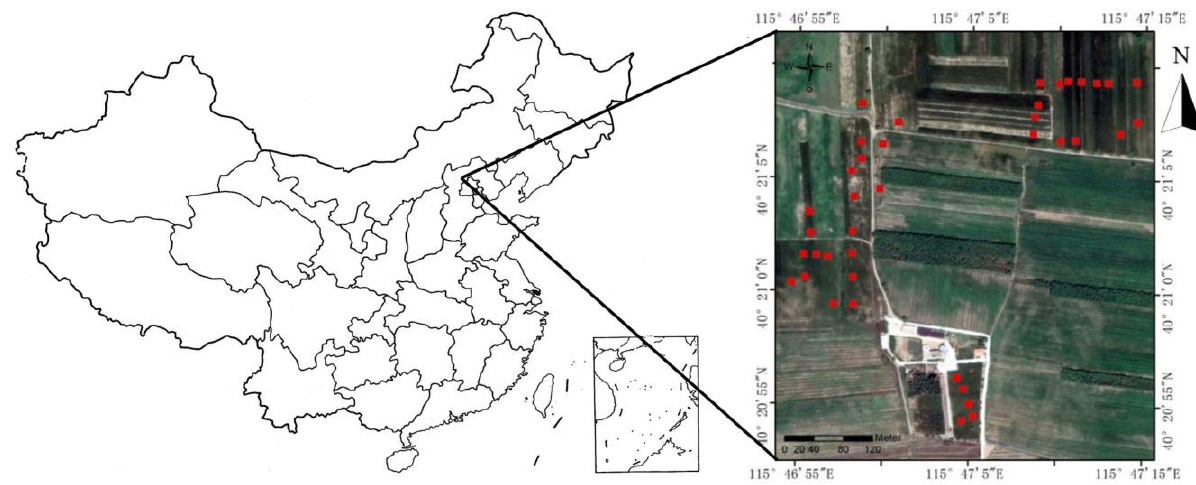
Figure 3. Study area and sampling plots